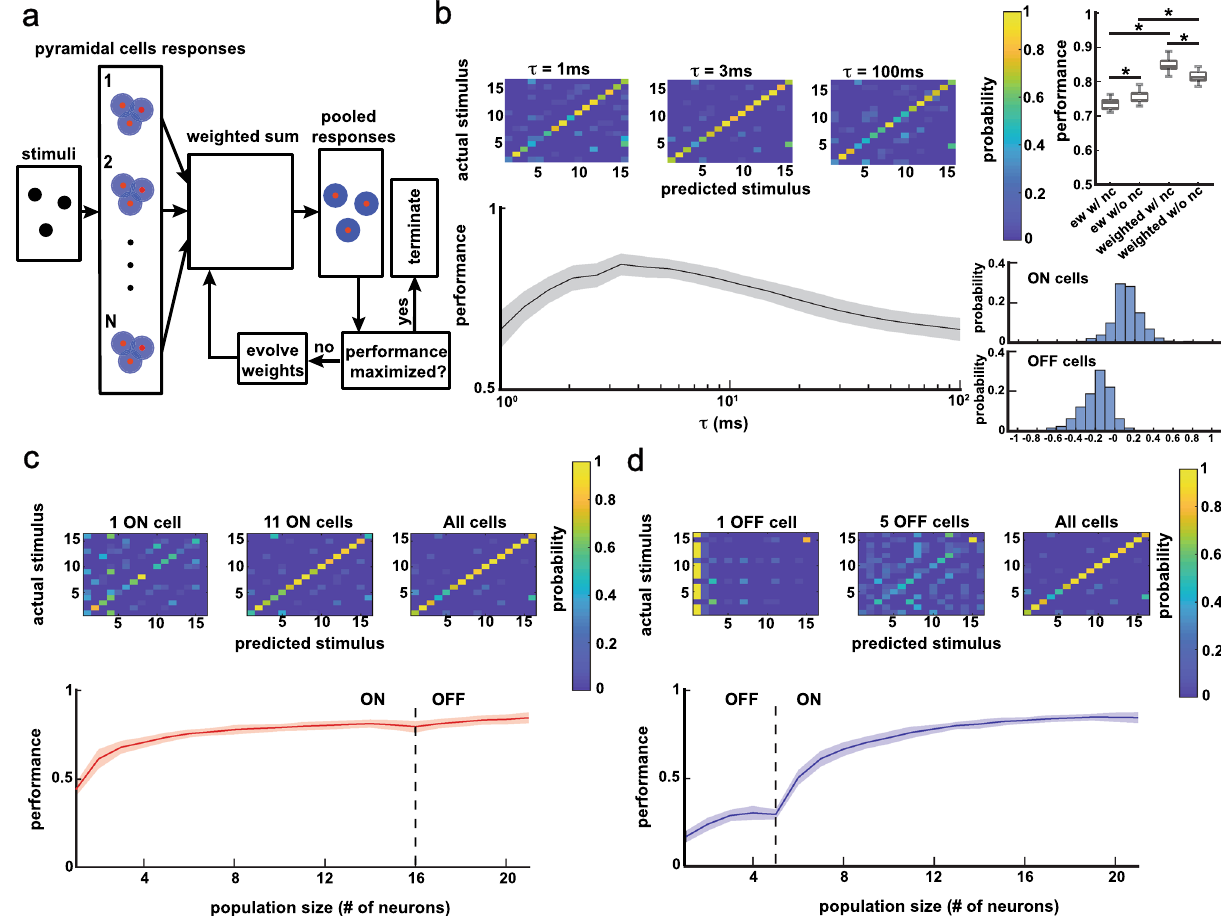
Figure 5. Discrimination performances of population activities when taking the weighted population sum. ( a ) Schematics showing how the responses of ELL pyramidal cells were summed with different weights assigned for different neurons. The weights were generated by an evolutionary algorithm. If the weights generated gave a better performance, they replaced the previous weights; if the weights generated did not improve the performance for 10 iterations (performance maximized), the evolutionary algorithm was terminated (see “Materials and methods” for details). ( b ) Left top: confusion matrices where each entry is the probability of a stimulus i predicted as stimulus j (prediction based on the distance between neural responses quantified by van Rossum metric with timescale τ, see “Materials and methods” for details) for a population of 21 neurons consisting of 16 ON and 5 OFF cells with τ = 1, 3 and 100 ms. Left bottom: discrimination performance as a function of τ. The shaded areas represent standard deviation of performance from different simulations of the evolutionary algorithm (30 in total), and same for ( c ) and ( d ). The range of τ values for which performance was higher than 90% of the maximum is 5.3 ms, which is similar to that obtained in the equal-weighted case (Fig. 4b). Right top: boxplots showing that weighted sums of neural activities improved performance for both with and without noise correlations (with noise correlations, one-way ANOVA, p = 1.1 × 10 –39 ; without noise correlations, one-way ANOVA, p = 8.7 × 10 –19 ); also, equal-weight sum of neural activities without noise correlations had better performance than those with noise correlations (one-way ANOVA, p = 1.3 × 10 –4 ), while weighted sum of neural activities with noise correlations had better performance than those without noise correlations (one-way ANOVA, p = 5.3 × 10 –19 ). Right bottom: the probability distributions of weights assigned to ON cells and OFF cells over 30 runs of the evolutionary algorithm. ( c ) The effect of population size on discrimination performance. ON cells were first considered before OFF cells. Top: confusion matrices for populations of 1 ON cell, 11 ON cells, and all cells (16 ON cells and 5 OFF cells) with τ = 3 ms. Bottom: discrimination performance as a function of population size. ( d ) Same as ( c ) but now OFF cells were first considered before ON cells. Top: confusion matrices for populations of 1 OFF cell, 5 OFF cells, and all cells (16 ON cells and 5 OFF cells) with τ = 3 ms. Bottom: discrimination performance as a function of population